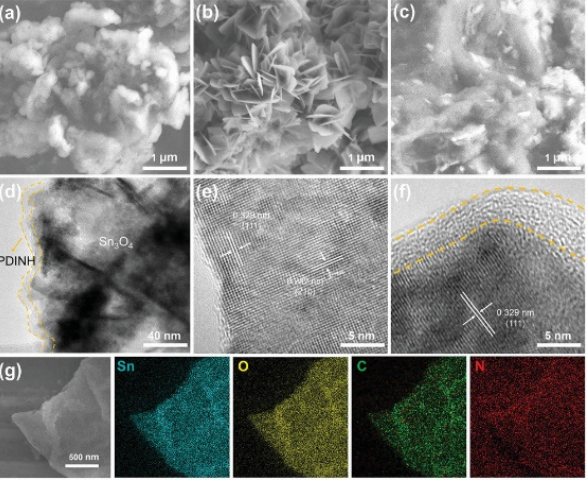
Figure 15. SEM images of ( a ) PDINH, ( b ) Sn 3 O 4 , and ( c ) Sn 3 O 4 /PDINH − 10%. ( d ) TEM image of Sn 3 O 4 /PDINH − 10%. HRTEM images of ( e ) Sn 3 O 4 and ( f ) Sn 3 O 4 /PDINH-10%. ( g ) EDS element mapping of Sn 3 O 4 /PDINH − 10%.